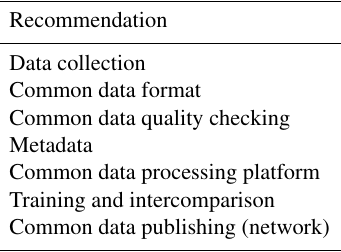
Table B1. Summary of recommendations for Indonesian observa-